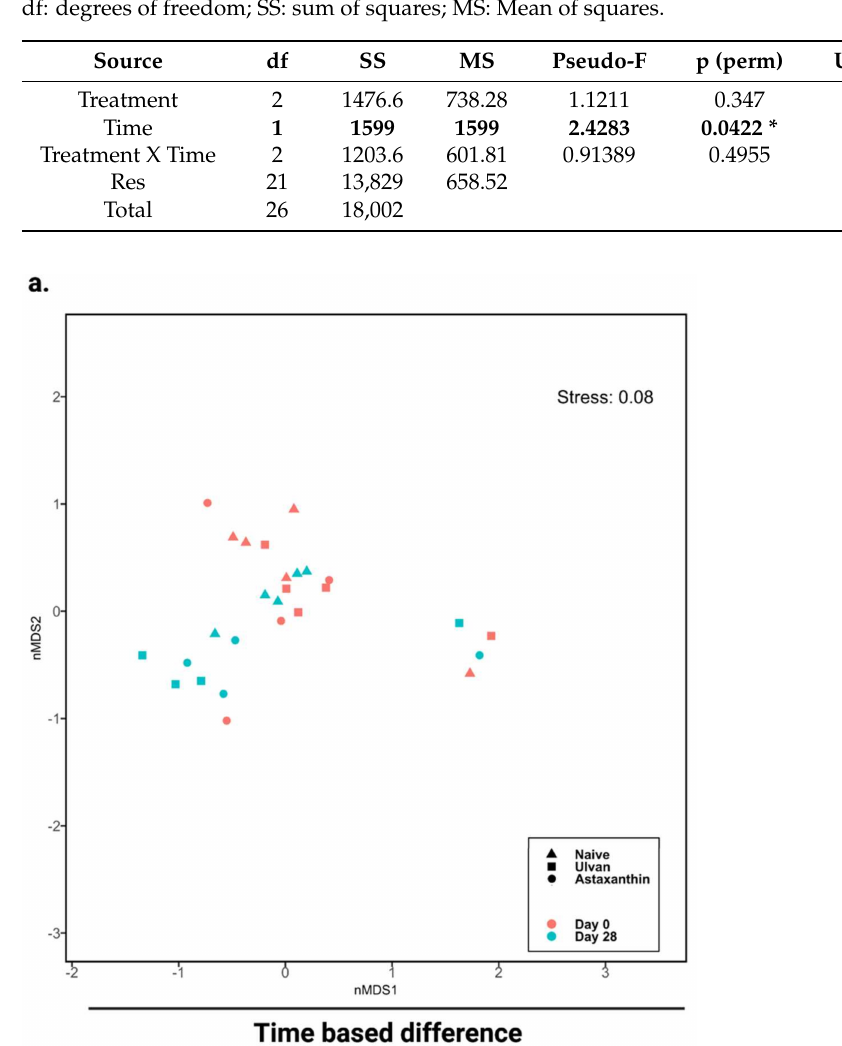
Table 1. PERMANOVAs based on Bray–Curtis (BC) similarity measure for square-root transformed